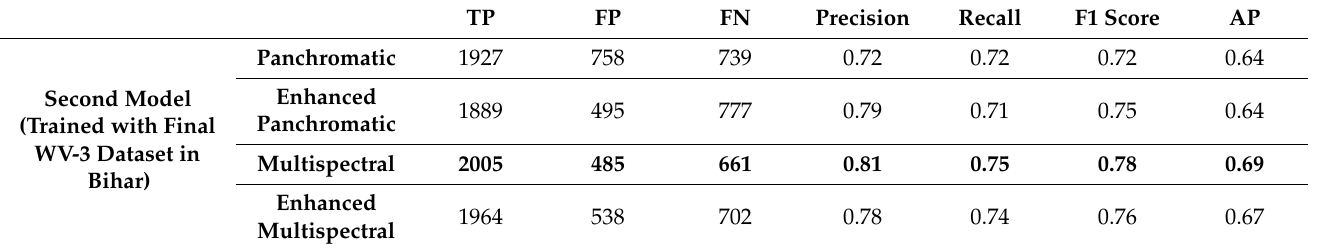
Table 6. Detection accuracy of mapping smallholder field boundaries in Uttar Pradesh with models trained using WV-3 data in Bihar. The accuracy metrics from the model with the best F1 score and AP values are highlighted in bold. TP FP FN Precision Recall F1 Score AP